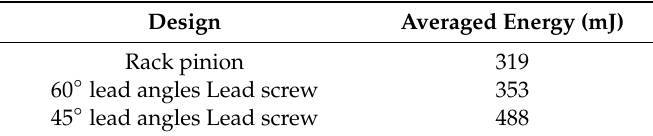
Table 4. Comparison of Rach-Pinion, Lead-Screw (60 ◦ lead angles) and Lead-Screw (45 ◦ lead angles) Average